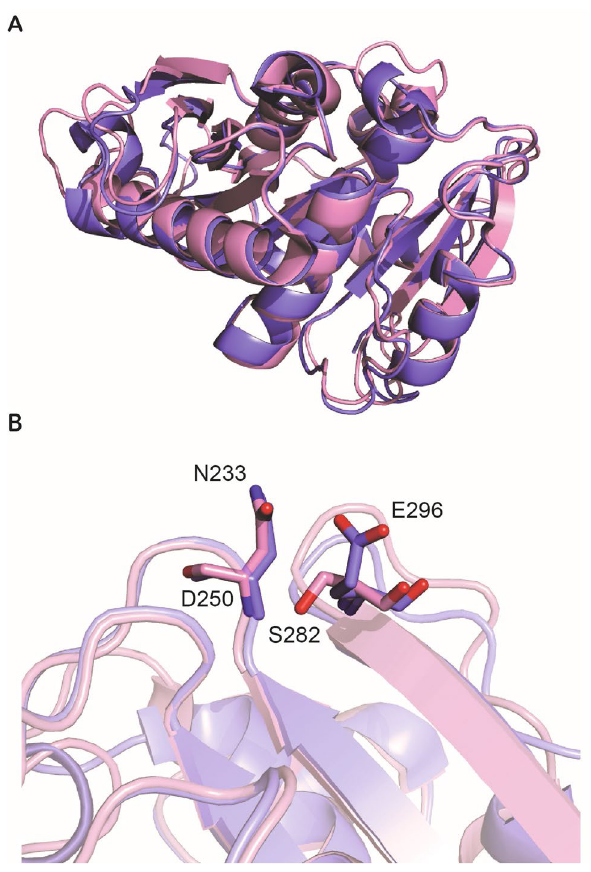
Figure 1. Homology alignment between Is PETase and Cut190*. ( A ) PyMOL structural alignment of Cut190* with Is PETase. MacPyMOL (ver 1.8.6.2) was used to perform the structural alignment 32 . Is PETase is pink (PDB: 6EQE 13 ); Cut190* is blue (PDB: 5ZNO 5 ). ( B ) Residues mutated to generate disulfide bridge in Cut190* (E296 and D250) align with S282 and N233 in Is PETase.